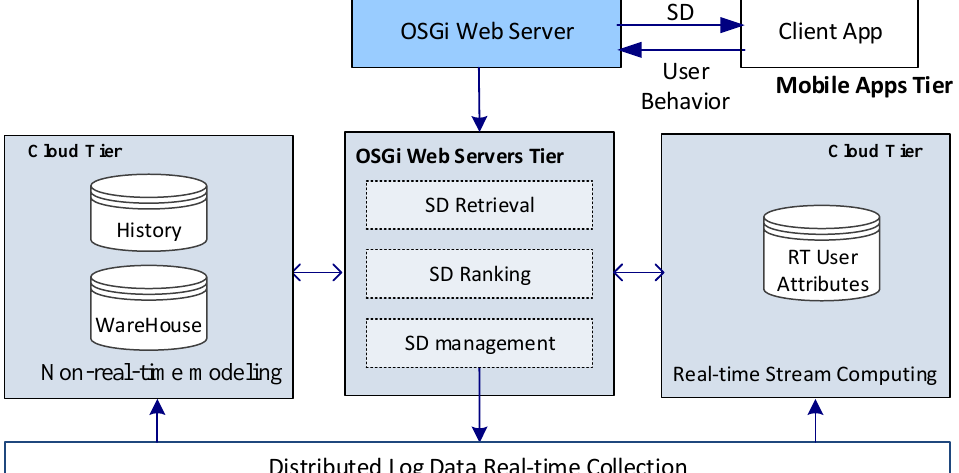
Figure 8. The main components of the cloud-based car parking